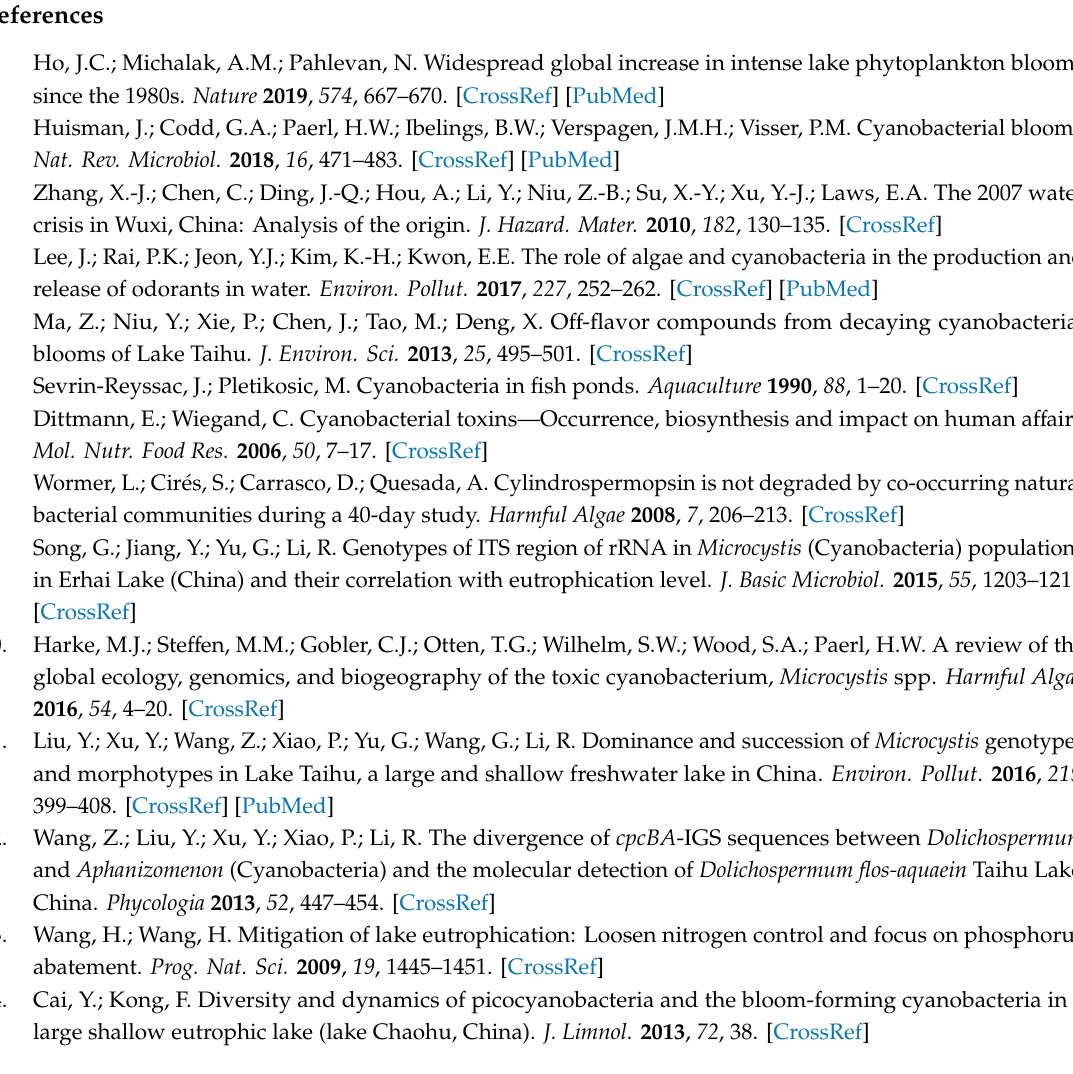
Figure S1: Length distribution of high-quality sequences, Figure S2: Rarefaction curves of OTU richness (A), Chao 1 index (B), and Shannon index (C) against the number of sequences, Figure S3: Unrooted neighbor-joining tree of representative cpcBA -IGS sequences from 52 OTUs and reference cyanobacterial strains. Genbank accession number of each reference sequence was displayed before the species name. Bootstrap values above 50% are indicated at the nodes of the tree, Table S1: Detailed information of samples and number of robust reads, Table